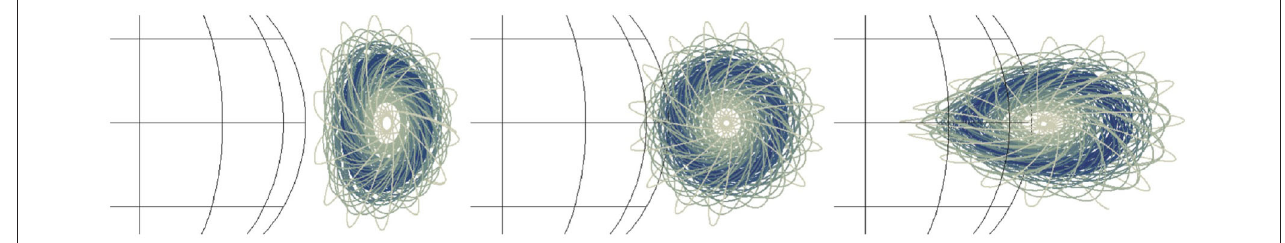
FIGURE 2 | Flux rope which correspond to different values of the stretching parameter a . Left : a < 0, middle : a = 0, right : a > 0. The exact values are a = − 0.5 R ⊙ , a = 0 R ⊙ , and a = 0.8 R ⊙ , respectively. The values of the other parameters used in this illustration are: f = 1.95 R ⊙ , (cid:127) = 50 ◦ , σ = 90 ◦ , and θ = 0 ◦ .